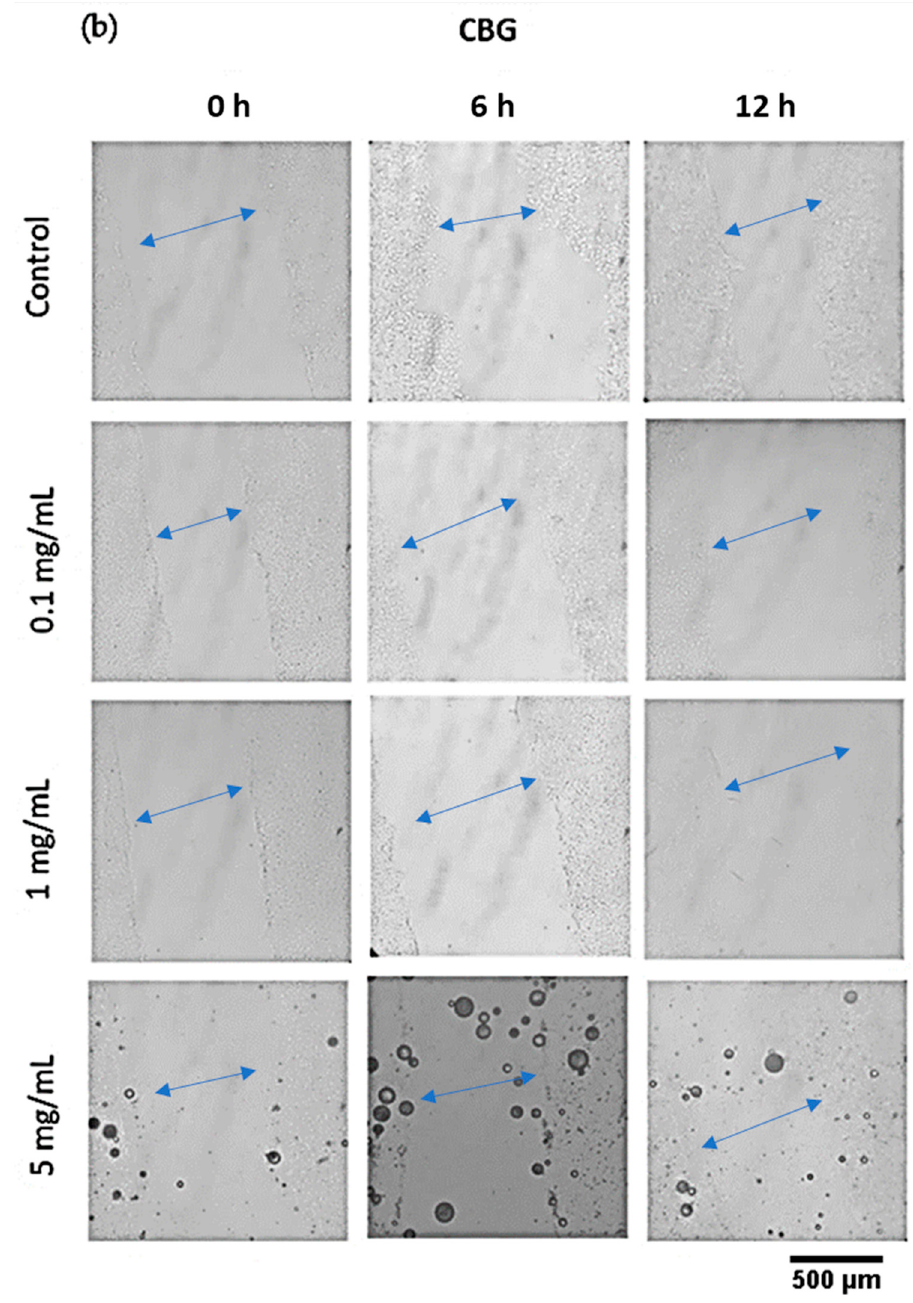
Figure 12. Time-Lapse of the in vitro wound healing process for various concentrations (0.1, 1 and 5 mg/mL) of ( a ) CBD and ( b ) CBG nanoparticles in the cell culture medium (100× magnification). Blue arrows show the scratch surface in the every time point.